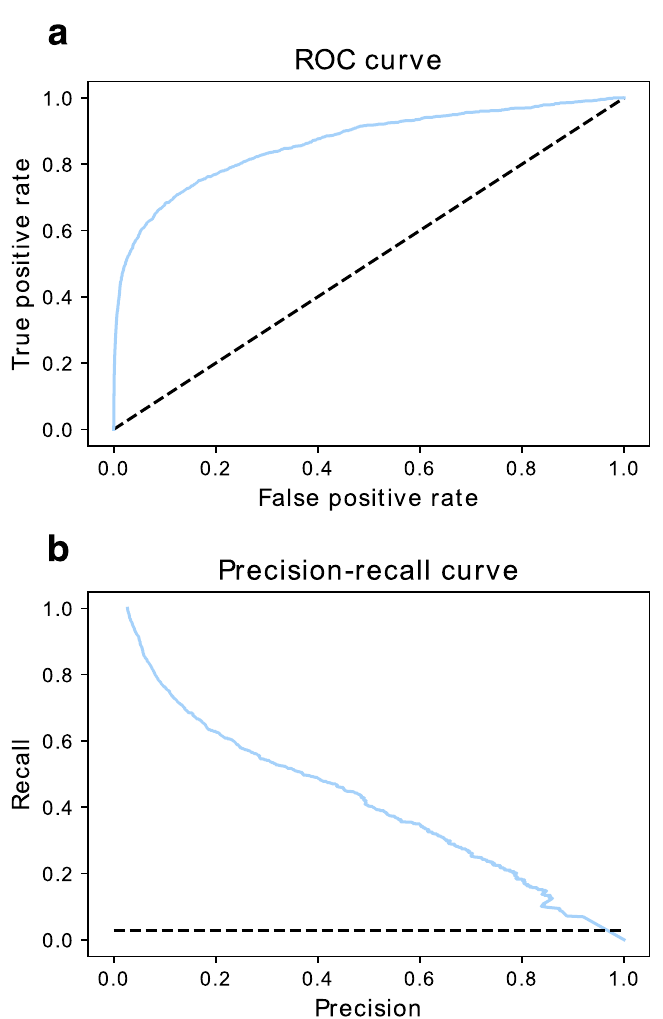
Figure 3. ROC and precision-recall curves for the final model trained with H-2K b samples. ( a ) ROC curve for 10% test partition with an AUC of 86.5%, the dashed line shows chance level. ( b ) Precision-recall curve with the prevalence of around 3% shown as chance. The precision-recall AUC is 41.97%, whereas a random guess corresponds to an AUC of 2.64% for the same data